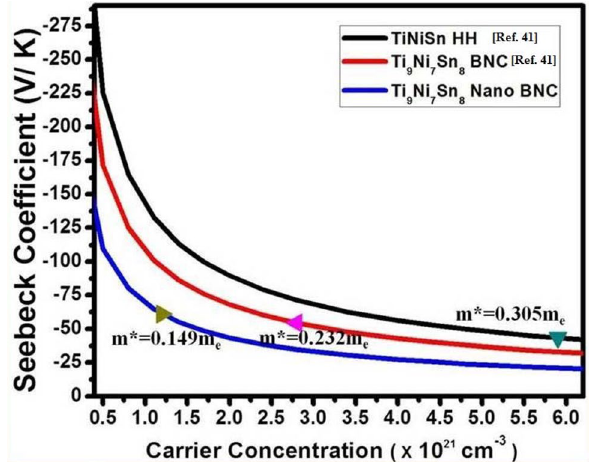
Fig. 3 Pisarenko plot at 323 K showing the dependence of the See- beck coefficient α ( T ) on the electron carrier concentration (solid line) for Ti 9 Ni 7 Sn 8 Nano-BNC and compared with that of TiNiSn (HH) and